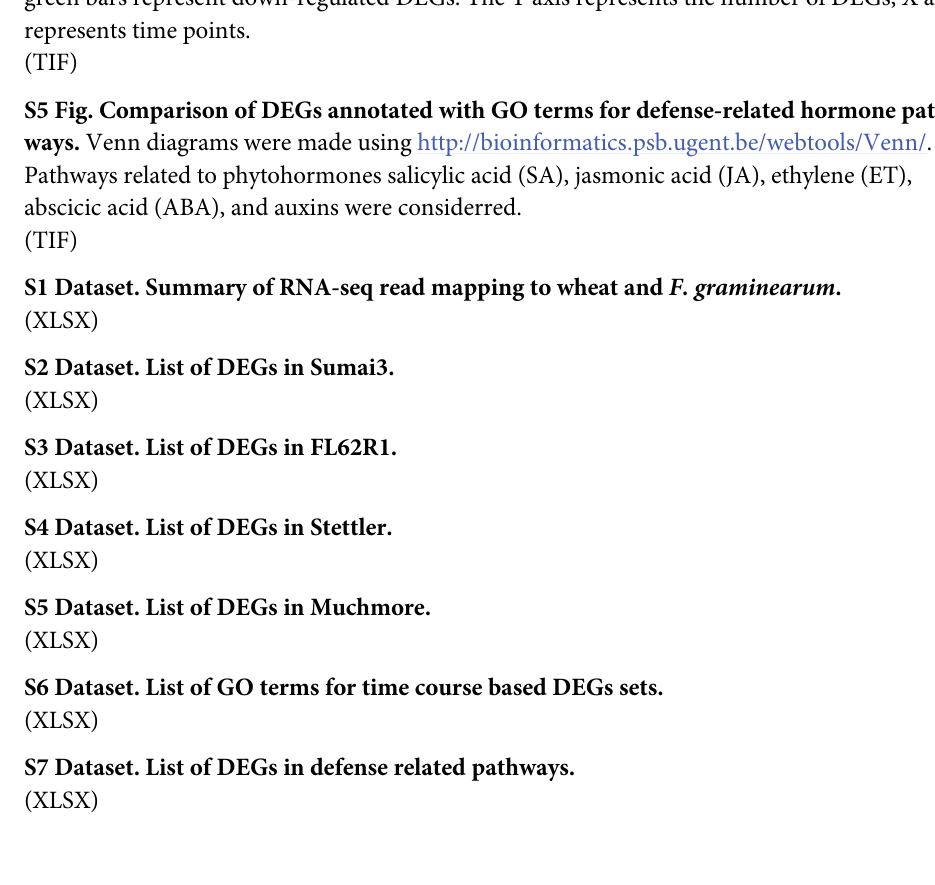
S1 Fig. The macroscopic symptoms of F. graminearum infection on spikelets at one week after point inoculation. Photographs were taken of the entire inoculated spikelet and adjoin- ing rachis (A), and of the individually excised organs of the inoculated spikelet, lemma (B), glume (outside, C; inside, D), and rachilla (E). S2 Fig. Microscopic observation of the F. graminearum infection process in the inoculated spikelets. The individually excised organs of inoculated spikelet, lemma (A), palea (B), glume (C), and rachilla (D) were examined at different days after inoculation. All organs were stained with WGA; rachillas were additionally stained with the phloroglucinol-HCl solution to indi- cate lignification. Samples were separately photographed under fluorescence (left-side photo) and light (right-side photo) microscopy. Fungal hyphae appear in green under fluorescence. Lignin appears as red under light microscopy. The scale bar indicates 200 μ M. Each row of photographs represents the same time point among four varieties. S3 Fig. Overview of percentage of RNA-seq reads mapped to wheat and F. graminearum genomes. S4 Fig. Time course-based summary of DEGs sets, using the first time the gene becomes significantly activated (up) or repressed (down). Red bars represent up-regulated DEGs; green bars represent down-regulated DEGs. The Y axis represents the number of DEGs; X axis represents time points. S5 Fig. Comparison of DEGs annotated with GO terms for defense-related hormone path- ways. Venn diagrams were made using http://bioinformatics.psb.ugent.be/webtools/Venn/. Pathways related to phytohormones salicylic acid (SA), jasmonic acid (JA), ethylene (ET), abscicic acid (ABA), and auxins were